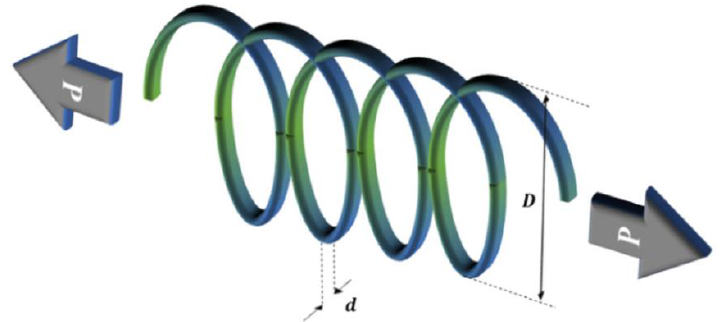
Figure 9. Structure of TCS.